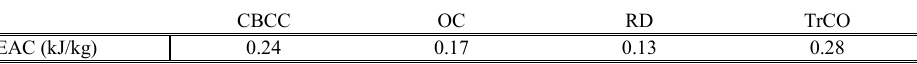
Table 3. EAC values for each cellular structure